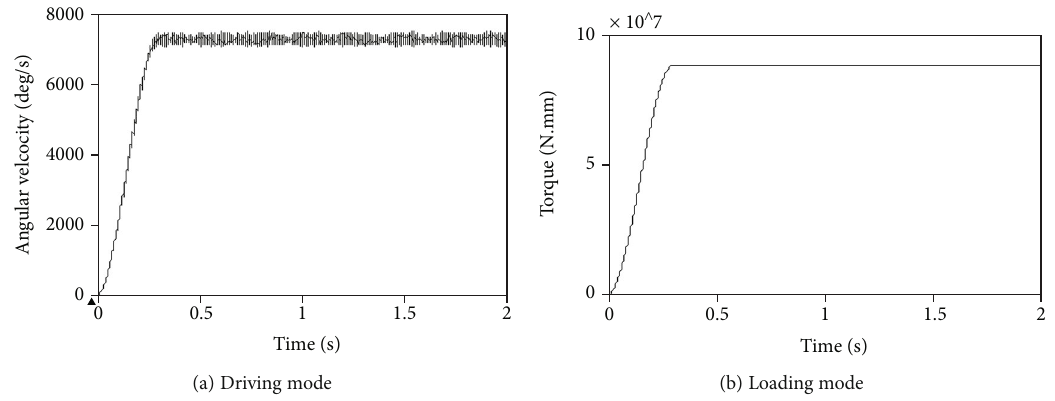
Figure 7: Simulation parameter